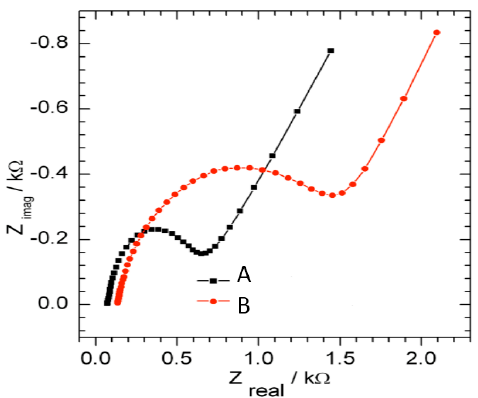
Figure 4. EIS Nyquist plots of the modified electrodes: ( A ) GCE SDD–Co(II) AgNPs; and